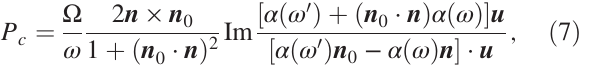
Circular polarization degree [ ]